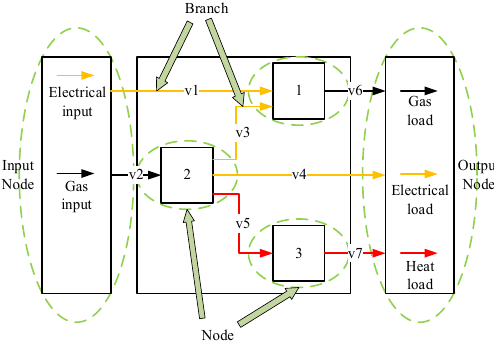
Figure 1. A graph theory perspective of EH.